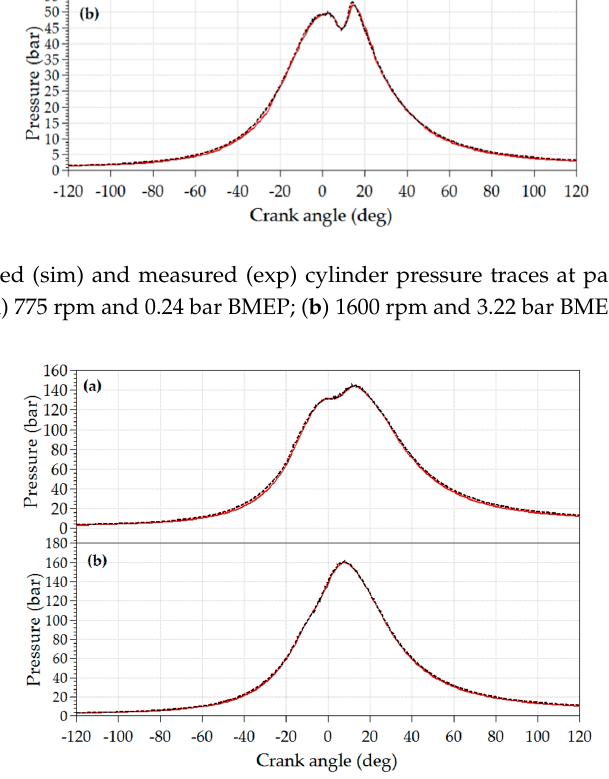
Figure 13. Simulated (sim) and measured (exp) cylinder pressure traces at full ‐ load steady ‐ state operating points: ( a ) 2600 rpm and 19.8 bar BMEP; ( b ) 3800 rpm and 15.0 bar BMEP.